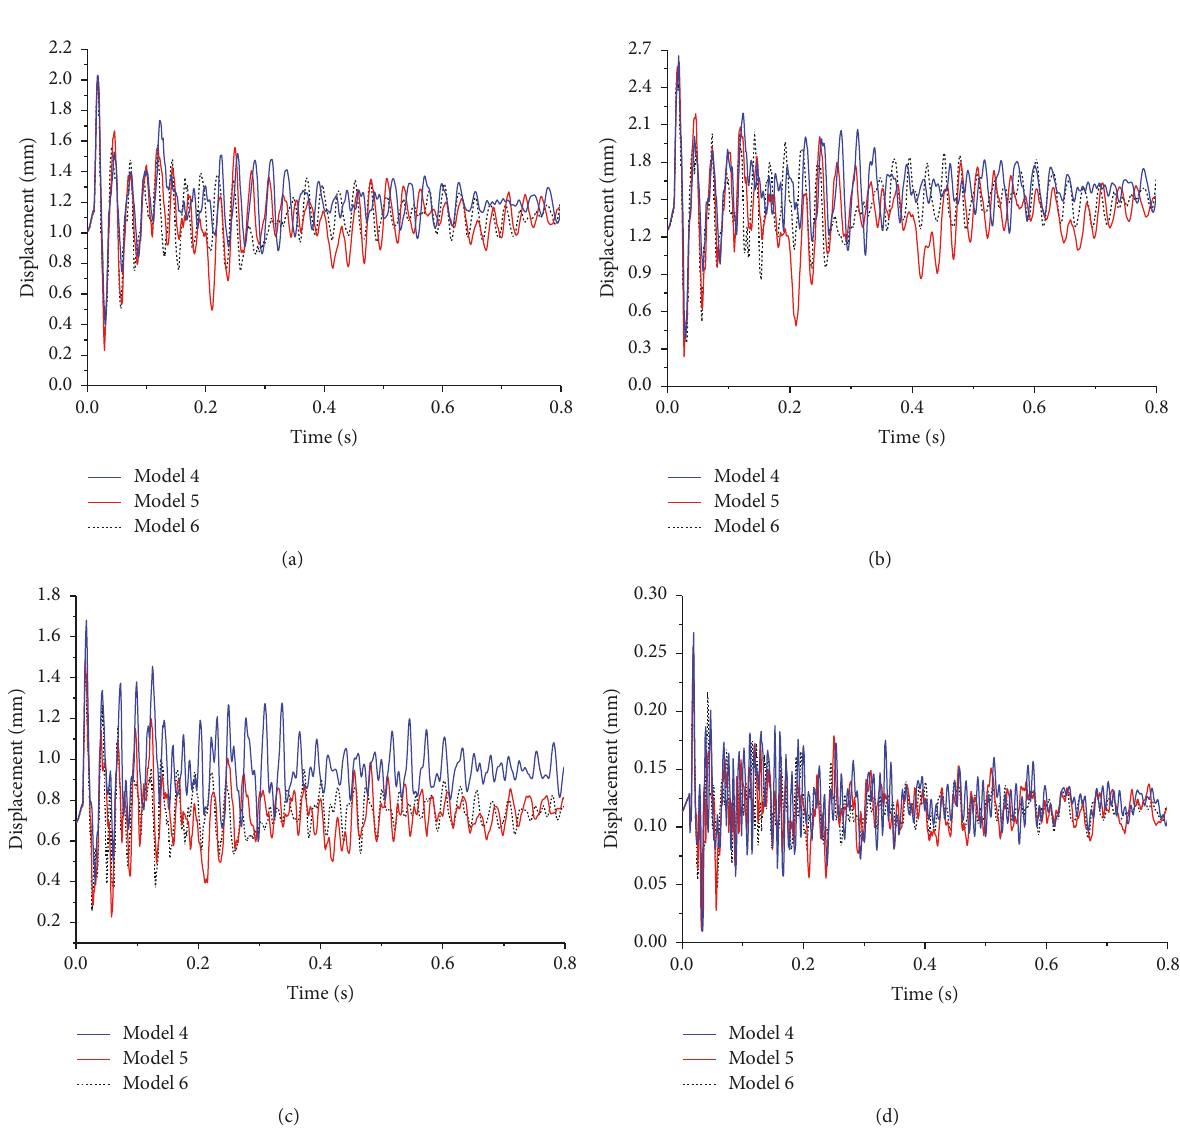
Figure 15: Node displacement-time curve: (a) node 1, (b) node 2, (c) node 3, and (d) node 4.